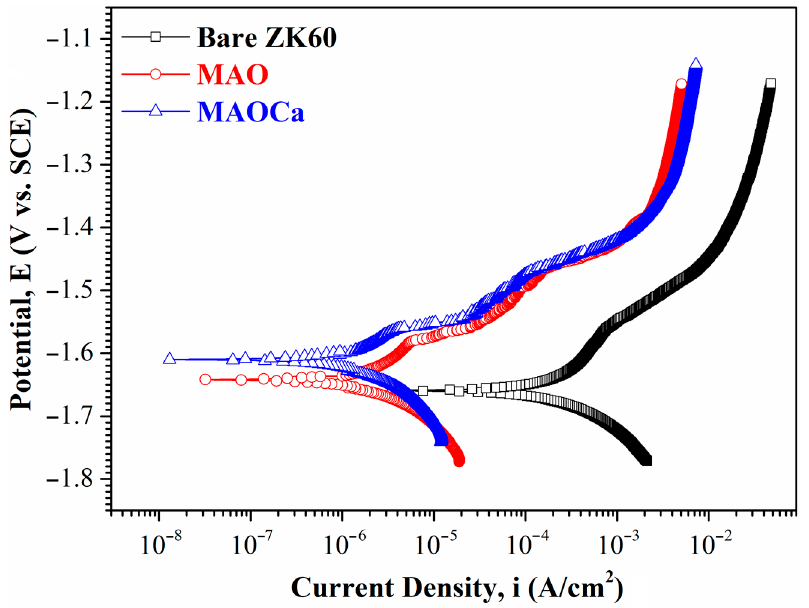
Figure 3. Potentiodynamic polarization curves in SBF solution for the bare ZK60 and samples coated in the MAO and MAOCa treatments.